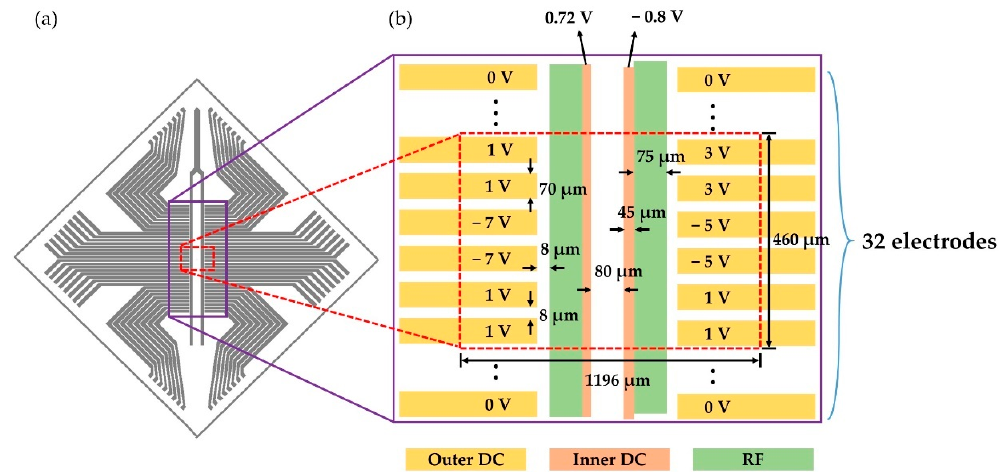
Figure 2. Comparison of the electrode layout of the entire surface ion trap chip and the numerical simulation. ( a ) Layout of the top layer electrodes in the surface trap used for the measurement. ( b ) Dimension of the electrodes near the trapping region (not drawn to scale) and the DC voltages used in our simulation. Inner DC electrodes are 14 µm below the RF and outer DC electrodes. The dashed red box indicates the electrode geometry used in the numerical simulation. Note that the red box shows only a small part of the entire chip.